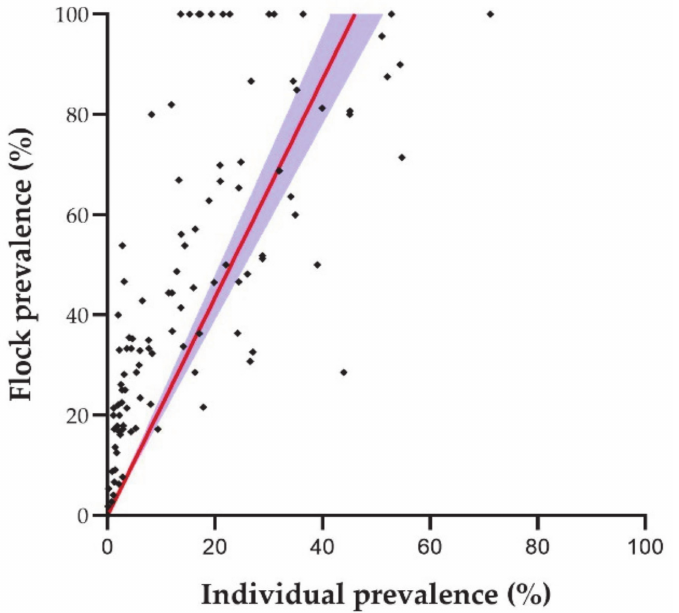
Figure 4. Correlation between individual and flock SRLV prevalence: dots are the data of each individual study (n = 118); the red line is the linear regression; and the blue area is the 95% confidence interval of the linear regression